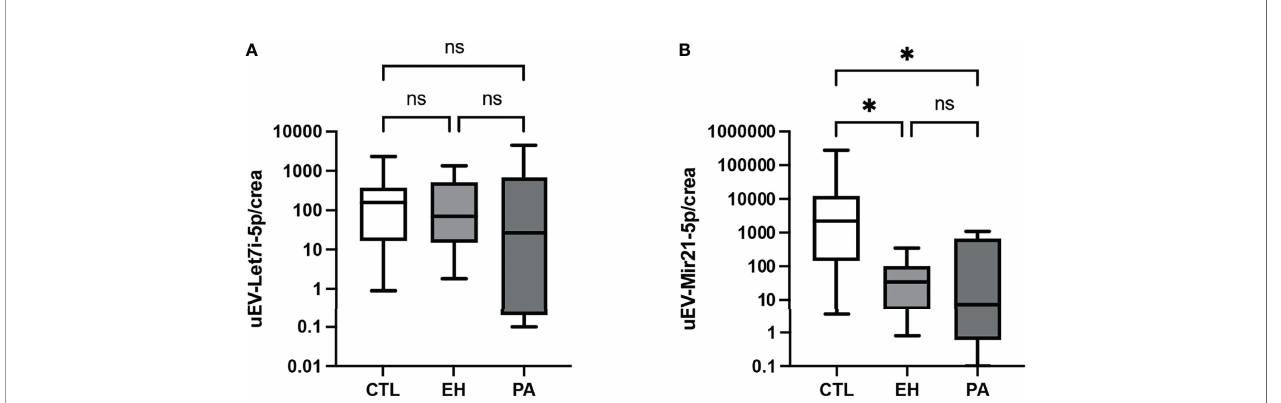
FIGURE 8 | Expression of miR-21-5p and Let-7i-5p in uEVs. (A) miR-Let7i-5p expression in uEVs normalized by urinary creatinine (RU/mg creatinine). No differences in miR-Let7i-5p levels were found between groups. (B) miR-21-5p expression in uEVs normalized by urinary creatinine (RU/mg creatinine). uEVs miR-21- 5p expression was higher in PA and EH subjects respect CTL group. Comparison between groups was performed by unpaired one-way ANOVA or Kruskal-Wallis test. Data are presented as a median and interquartile range [Q1-Q3]. N.S: No signi fi cative difference, *p < 0.05.